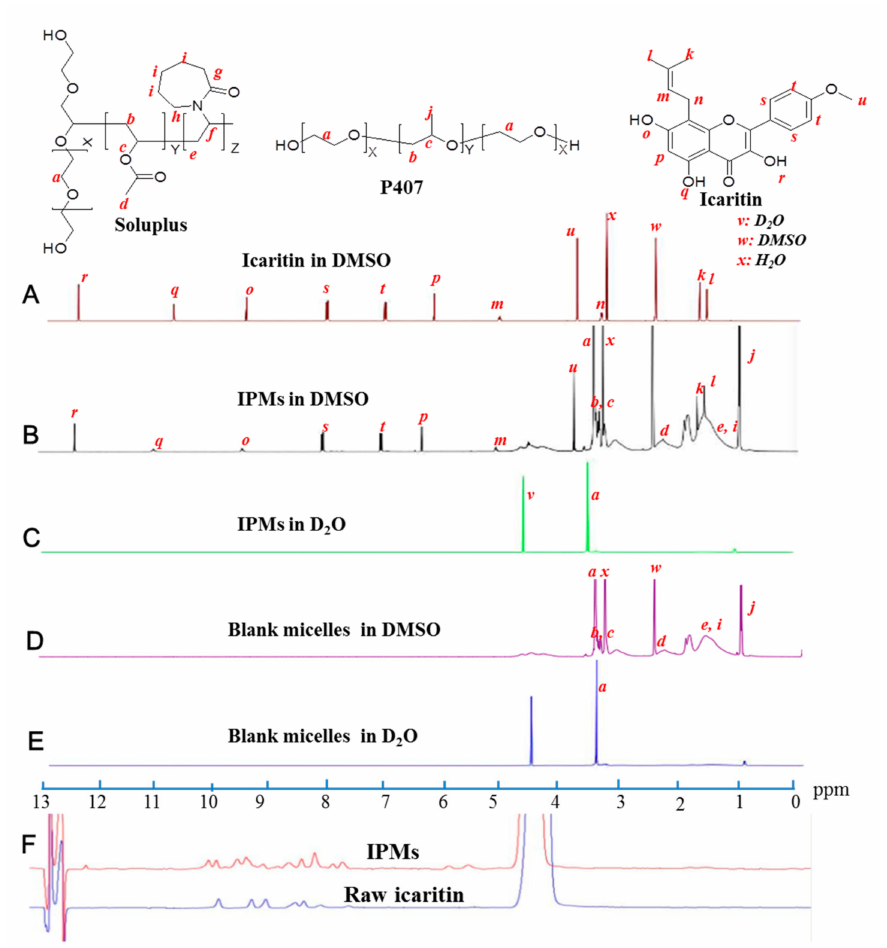
Figure 2. 1 H-NMR of icaritin in DMSO- d 6 ( A ), IPMs in DMSO- d 6 ( B ) and in D 2 O ( C ), and blank micelles in DMSO- d 6 ( D ) and in D 2 O ( E ). ( F ) The HPLC chromatograms of raw icaritin and the loaded icaritin in the micelles. DMSO, dimethylsulfoxide; HPLC, high performance liquid chromatography; IPMs, icaritin-loaded polymeric micelles; P407, poloxamer